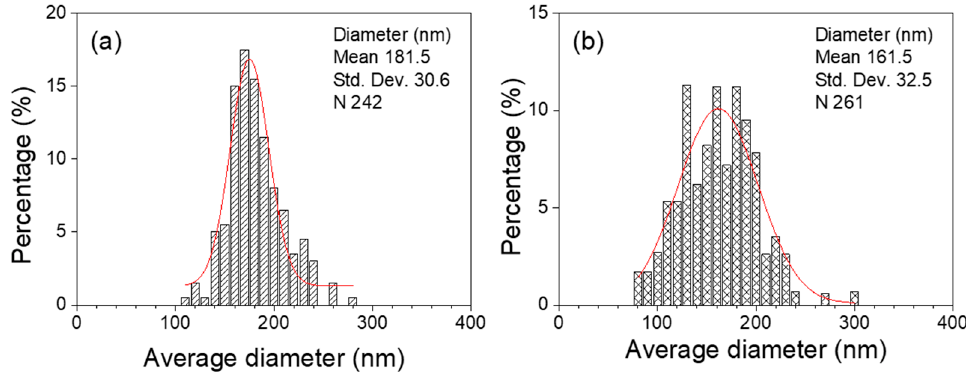
Figure 3. Diameter distribution histogram of nanofibers: ( a ) TiO 2 nanofibers and ( b ) Fe-doped TiO 2 nanofibers.